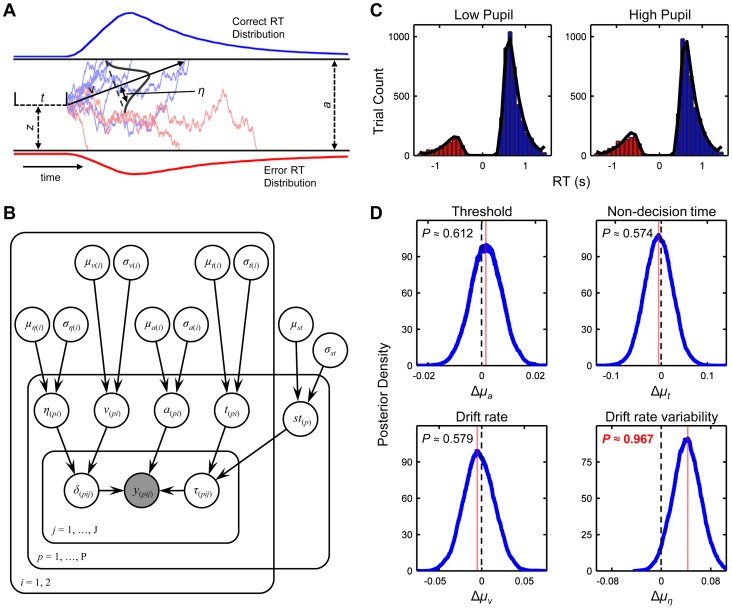
Drift diffusion modelling reveals a specific relationship between pupil diameter and variability in evidence accumulation rate.
A. Schematic representation of the drift diffusion model (DDM). Noisy sensory evidence is accumulated over time from starting point z at mean drift rate v, until one of two thresholds (separated by a) is reached and a decision is made. Non-decision-related processing time is accounted for by t. Drift rate is normally distributed across trials with standard deviation η. Upper and lower panels show simulated RT distributions for correct and incorrect decisions. B. Graphical representation of the hierarchical DDM that was fit to the observed behavioral data. Nodes receiving arrow projections in the graph denote distributions that are parameterized by the parent nodes. Subscripts represent baseline pupil diameter bin i, participant p, and trial j. The shaded node y indicates the observed bivariate accuracy and response time data. st = between-trial variability in t. Starting point z was fixed at a/2 across p, i and j (not shown). C. Model predictions after hierarchical parameter estimation, illustrating the fit of the model to the observed data sorted into two bins according to baseline pupil diameter. Negative distributions indicate error RTs. Histograms illustrate observed data; overlaid lines show predictions. D. Bayesian posterior distributions representing the effect of pupil diameter bin (high – low) on selected model parameters. The μ notation refers to the estimated mean of the group-level distribution for each parameter. P denotes the mass of the effect distribution that is above or below zero. Vertical red lines indicate distribution modes.